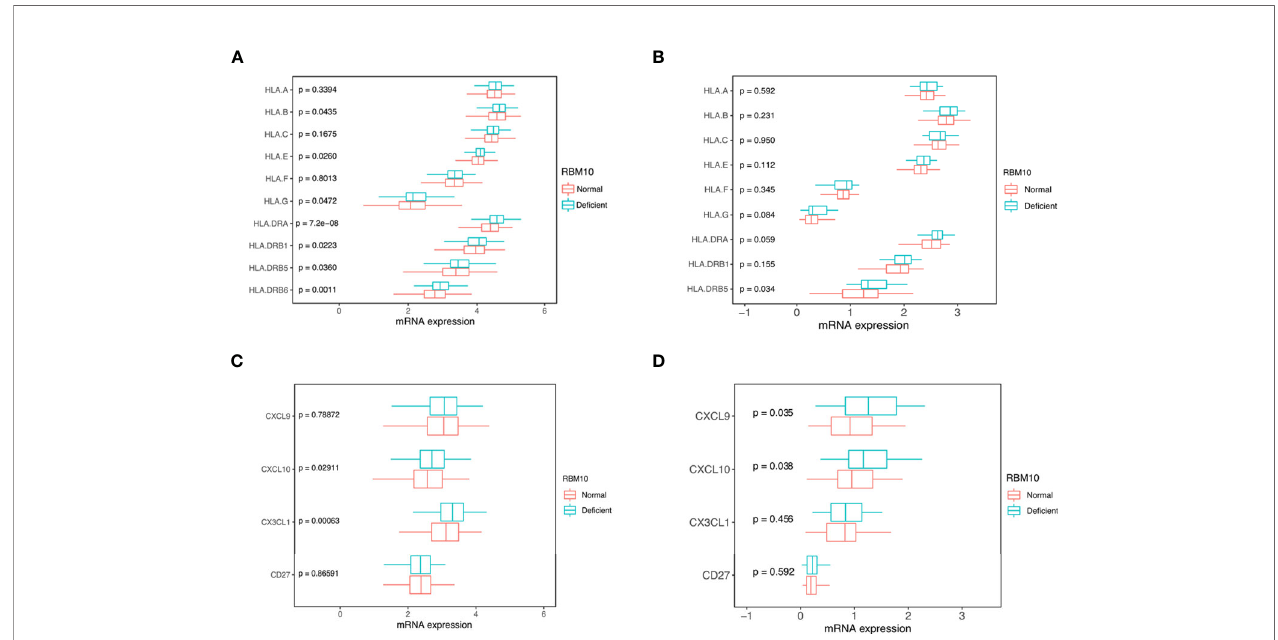
FIGURE 3 | RBM10 de fi ciency is associated with higher HLA and cytokine expression. (A, B) RBM10 de fi cient LUADs show higher HLA expression levels in both TCGA_LUAD cohort (A) and CHOICE_ADC cohort (B) . (C, D) RBM10 de fi ciency is also associated with elevated cytokines in both TCGA_LUAD (C) and CHOICE_ADC cohorts (D)